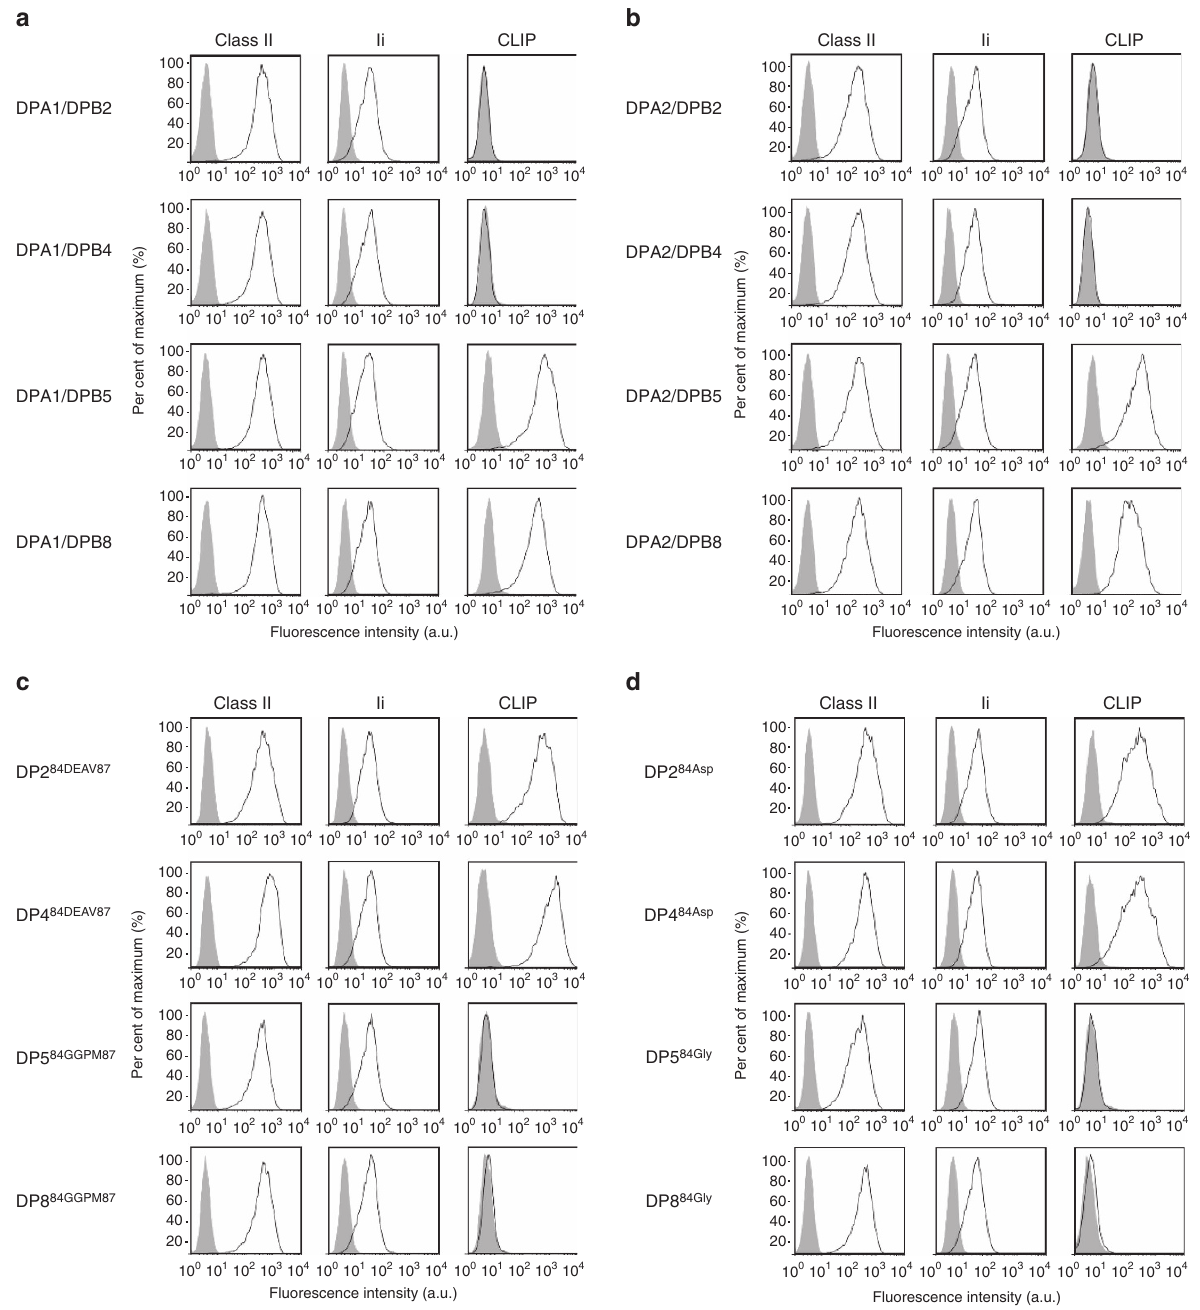
Figure 1 | HLA-DP molecules whose b -chains encode Gly 84 are unable to present CLIP. Surface class II, Ii and CLIP expression on T2 transfectants were analysed by flow cytometry following staining with specific monoclonal antibodies (mAbs). Note that T2 cells constitutively express Ii. ( a , b ) T2 cells were stably transduced with DPA1*01:03 (DPA1; a ) or DPA1*02:01 (DPA2; b ) in conjunction with DPB1 * 02:01 (DPB2), DPB1*04:01 (DPB4), DPB1*05:01 (DPB5) or DPB1*08:01 (DPB8). ( c ) T2 cells were stably transfected with DPA1 along with mutated DPB2 84DEAV87 (DP2 84DEAV87 ), DPB4 84DEAV87 (DP4 84DEAV87 ), DPB5 84GGPM87 (DP5 84GGPM87 ) or DPB8 84GGPM87 (DP8 84GGPM87 ), whose amino-acid residues at positions 84–87 of the DP b chain were substituted as indicated. ( d ) T2 cells were stably transfected with DPA1 in conjunction with mutant DPB2 84Asp (DP2 84Asp ), DPB4 84Asp (DP4 84Asp ), DPB5 84Gly (DP5 84Gly ) or DPB8 84Gly (DP8 84Gly ), where point mutations of the amino-acid residue at position 84 of each DP b chain were substituted as indicated. homozygous for both DP 84GGPM87 (DP4/4) and DP 84DEAV87 (DP5/17), DP/CLIP complexes were detected in only DP5/17, but not in DP4/4, EBV-LCL.